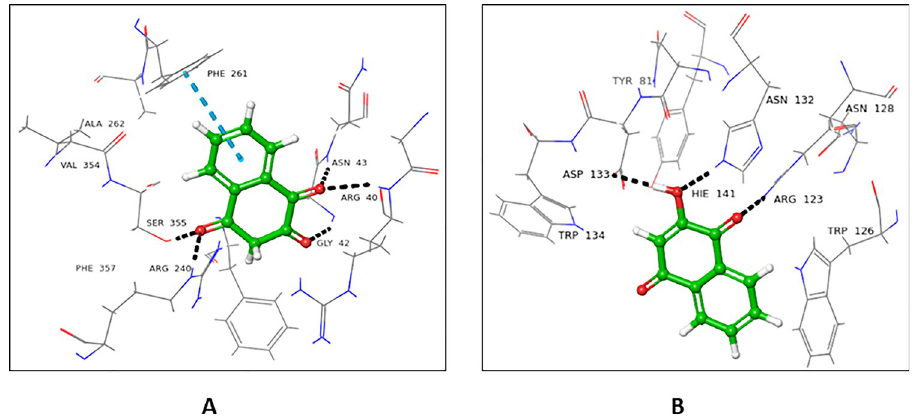
Fig 9. Interactions of compound 5 with the (A) donor and (B) acceptor domain of FUT2. 3D Ligand interactions diagram; blue dashed lines indicate π - π stacking bond, while black dashed lines show hydrogen